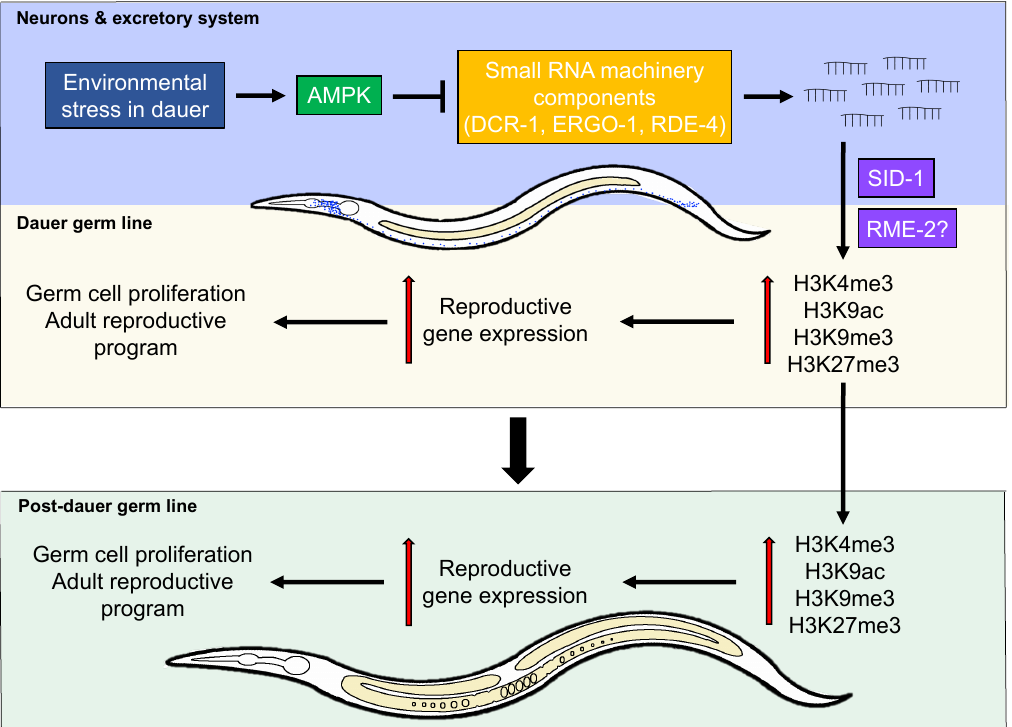
Figure 1. Regulation of germ cell integrity and germline quiescence by the endogenous small RNA pathway in Caenorhabditis elegans . Upon encountering environmental stress, the animal will enter the dauer stage. In this stage, AMPK is activated in the somatic tissues to somehow inhibit the biogenesis of endogenous small RNAs, preventing a population of small RNAs from inappropriately specifying chromatin changes typical of reproductive stages during the dauer diapause. These endogenous small RNAs use a double-stranded RNA importer SID-1, and perhaps a vesicle channel protein receptor-mediated endocytosis, RME-2, to import these small RNAs into the germ line. In doing so, AMPK activity promotes the establishment of a chromatin landscape that is consistent with quiescence in the germ line, preserving germ cell integrity over the duration of the dauer stage. When AMPK activity is reduced upon dauer exit, execution of the entire process will ensure the appropriate transition to post-dauer development, with a functional germ line that adequately supports